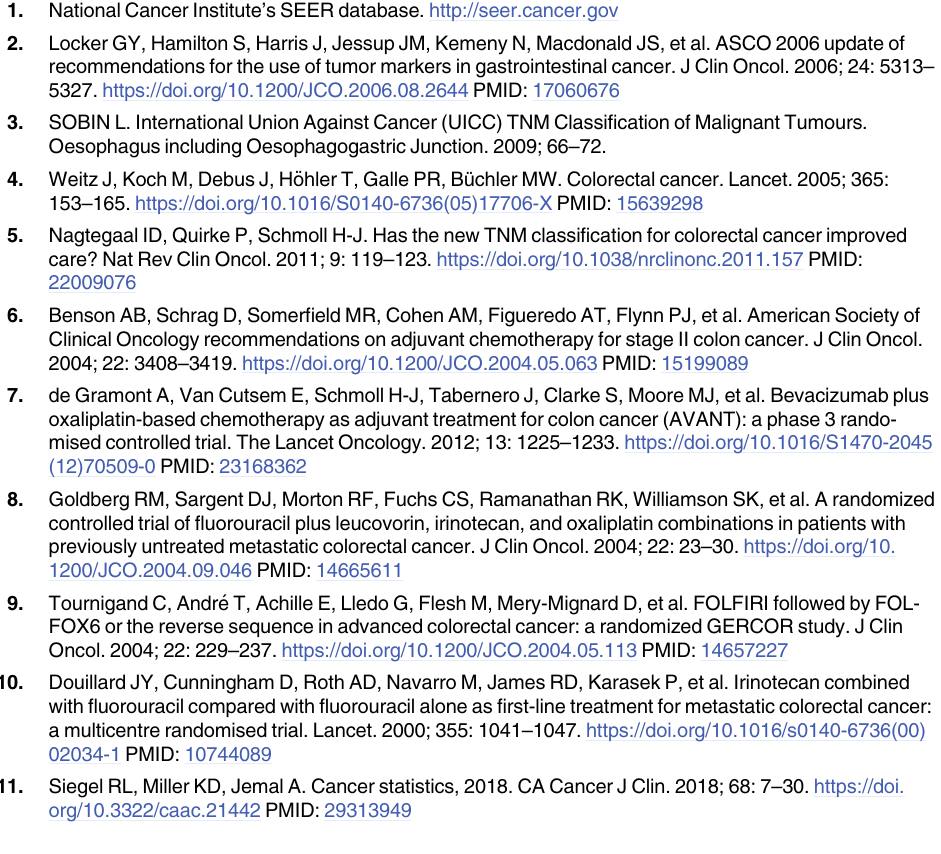
S6 Table. Prognostic signature specification including genes, model coefficients, and the biology captured by each signature